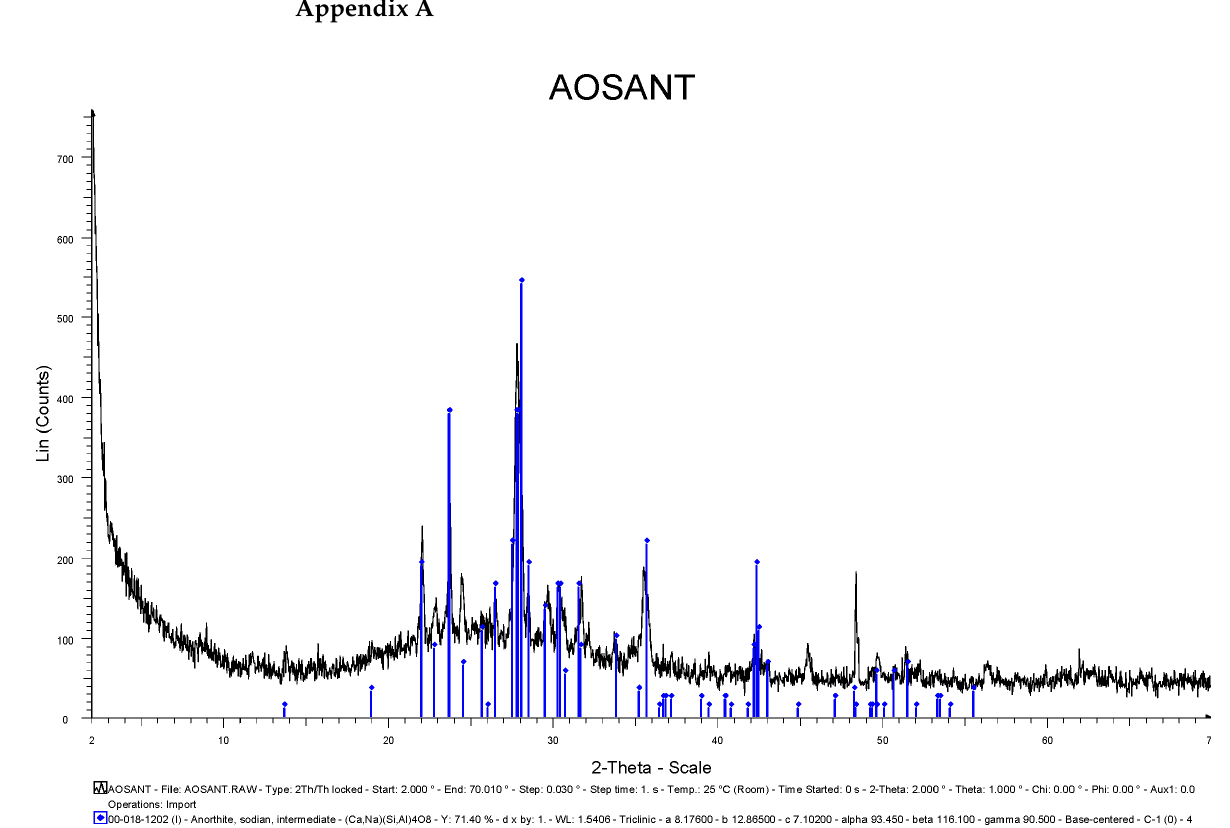
Figure A1. X-Ray Diffractogram showing the anorthite profile according to ASTM file number 00-018-1202.